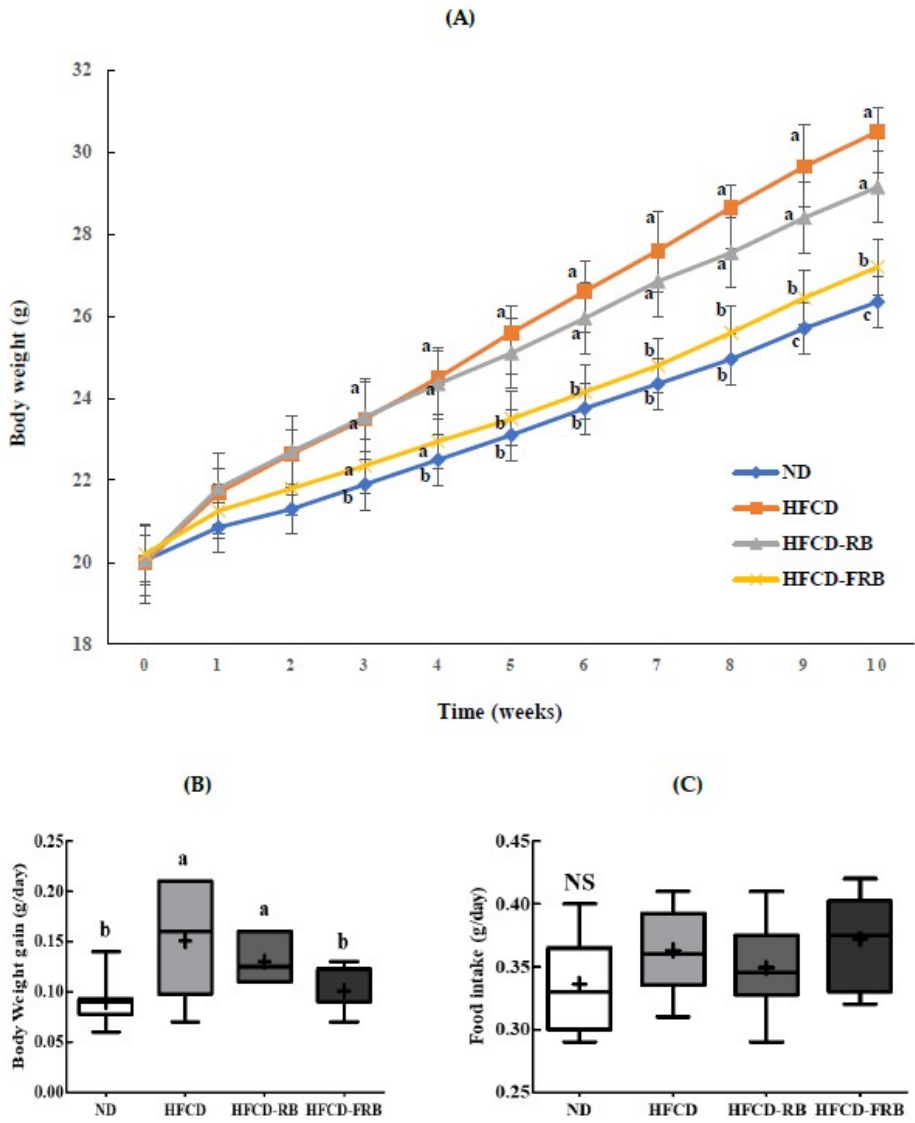
Figure 1. Body weight changes, daily body weight gain and daily average food intake in mice fed experimental diets for 10 weeks. Diet groups: ND, normal diet group; HFCD, high-fat and -cholesterol diet group; HFD-RB, HFCD + non-fermented rice bran powder group; HFCD-FCA, HFCD + fermented rice bran powder group. ( A ) Body weight was measured weekly, ( B ) daily body weight gain, and ( C ) daily average food intake were measured. Values are displayed as a Box-and-Whisker plot with means (expressed as ‘+’), n = 10. a-c: bars with different letters are significantly different at p < 0.05 by Tukey’s post hoc test. NS: Not significantly among the groups.